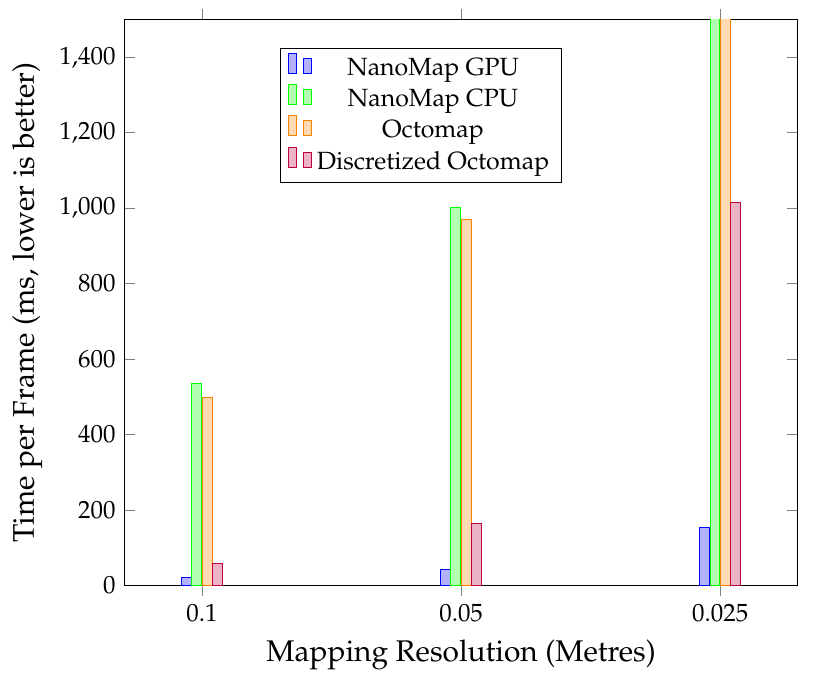
Figure 7. Nvidia Jetson-Nano NanoMap GPU vs. CPU performance (see Figure